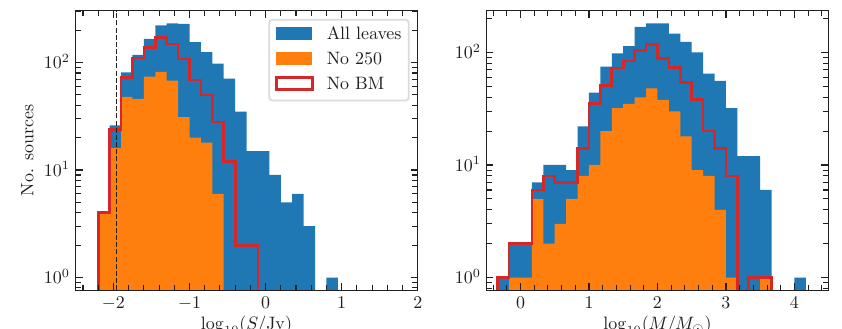
Figure 2. GASTON 1.2 mm compact source flux (left) and mass (right) distributions. The blue his- togram shows all GASTON sources identified. The red histogram shows GASTON sources that are not associated with a band merged (BM) Herschel clump [16]. The orange histogram shows GAS- TON sources that are not associated with a Herschel 250 µ m sources from [14] Hi-GAL catalogue. The vertical dashed line on the left panel shows the 3 σ 1 . 2 mm detection threshold for beam-size